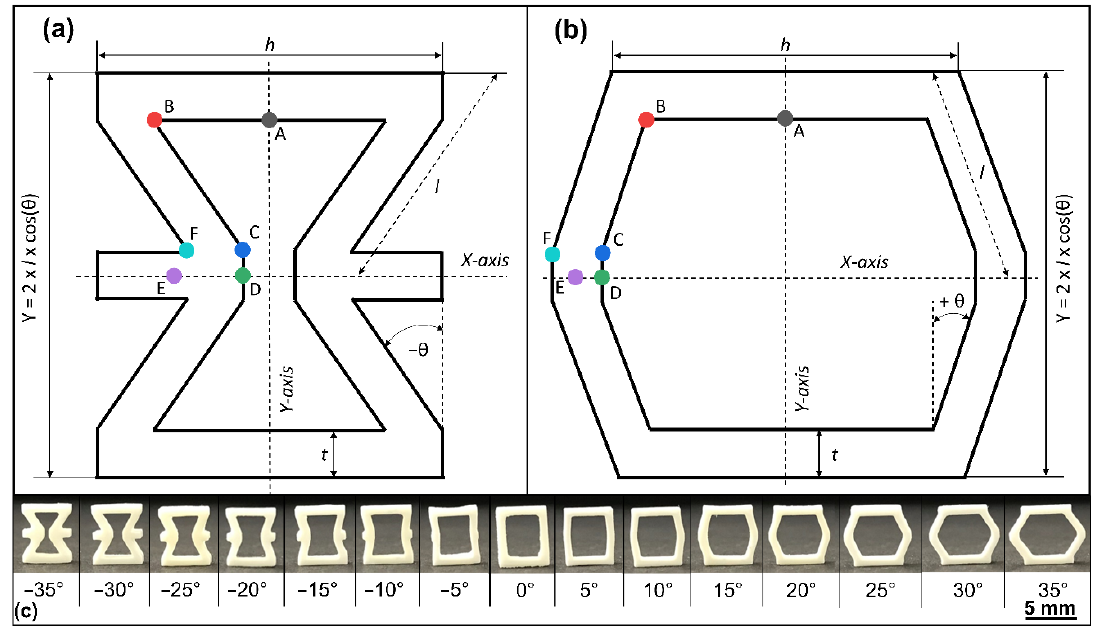
Figure 1. ( a ) Auxetic and ( b ) hexagonal unit cell with symmetry axes (X/Y) and structural parameters: strut thickness t , width h , angle θ , leg length l , and measuring points A − F for photoelastic stress measurement, ( c ) alumina unit cells with varying angle θ between θ = − 35° and 35°.